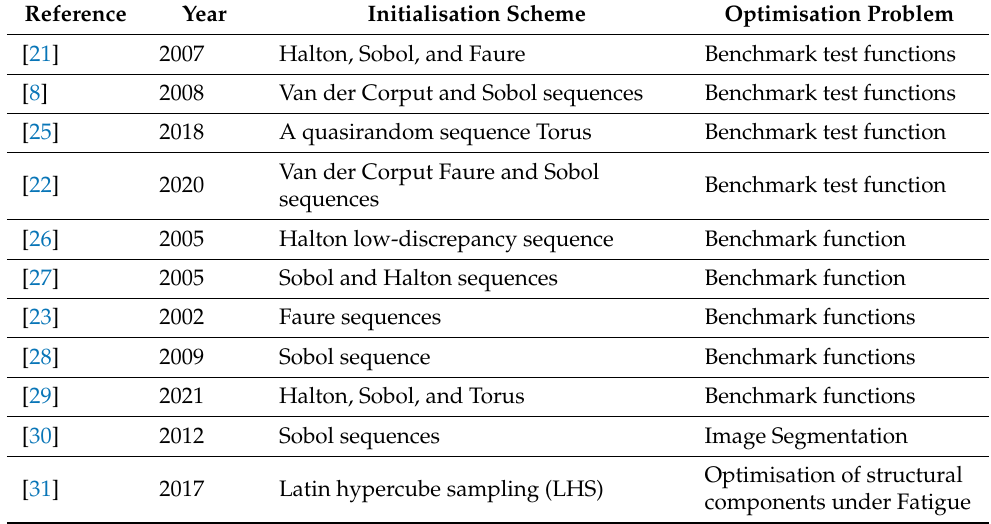
Table 2. Summary of quasirandom methods.